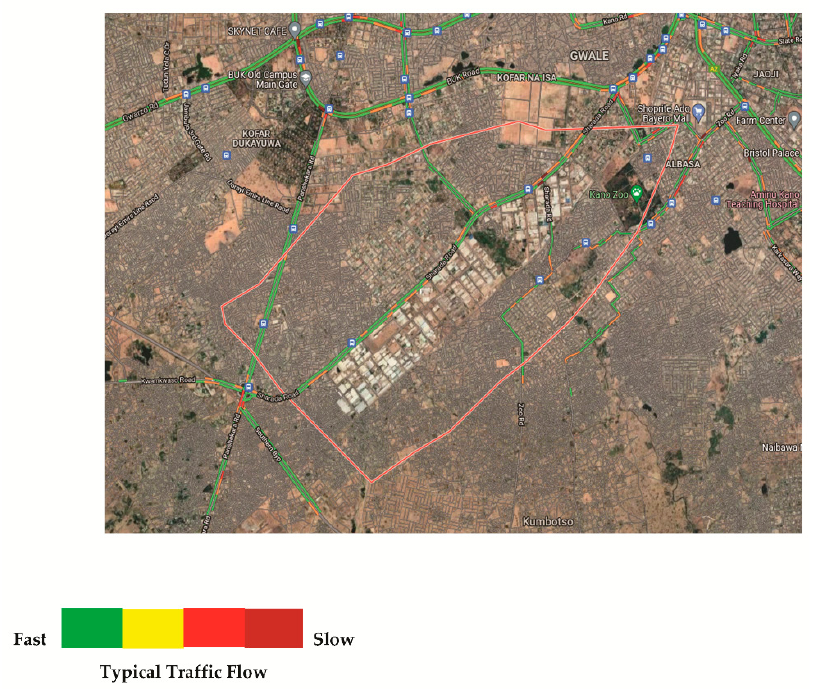
Figure A1. Map of Nigeria highlighting Kano State and satellite image of Kano Municipal Local Government Areas showing typical week day traffic (Source: Google maps ® ).